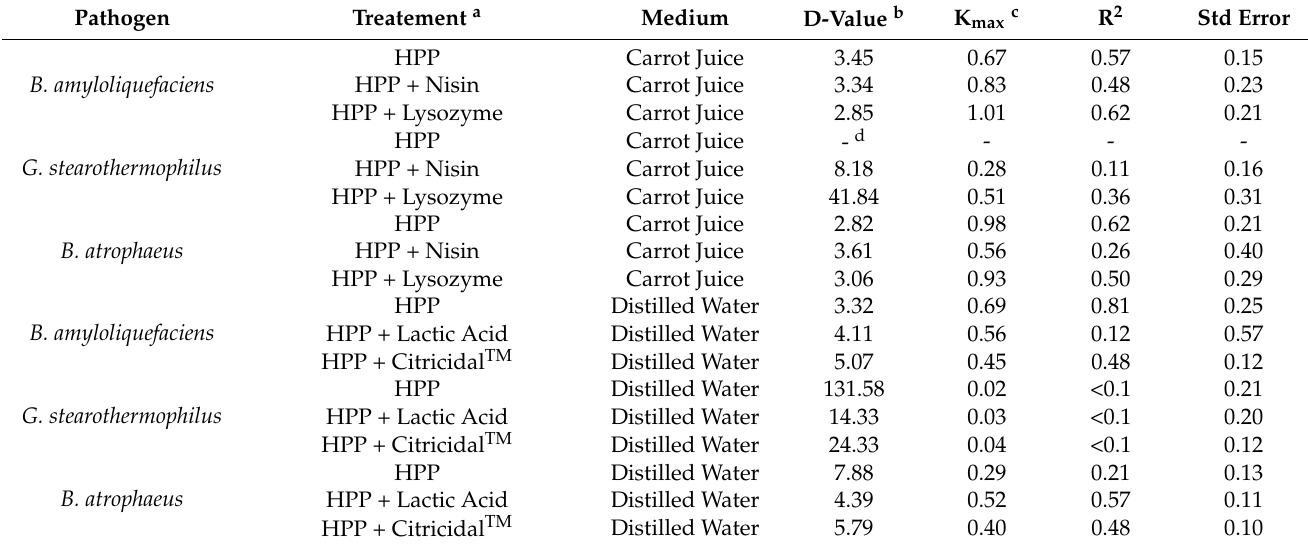
Table 1. Inactivation indices for B. amyloliquefaciens , G. stearothermophilus , and B. atrophaeus .